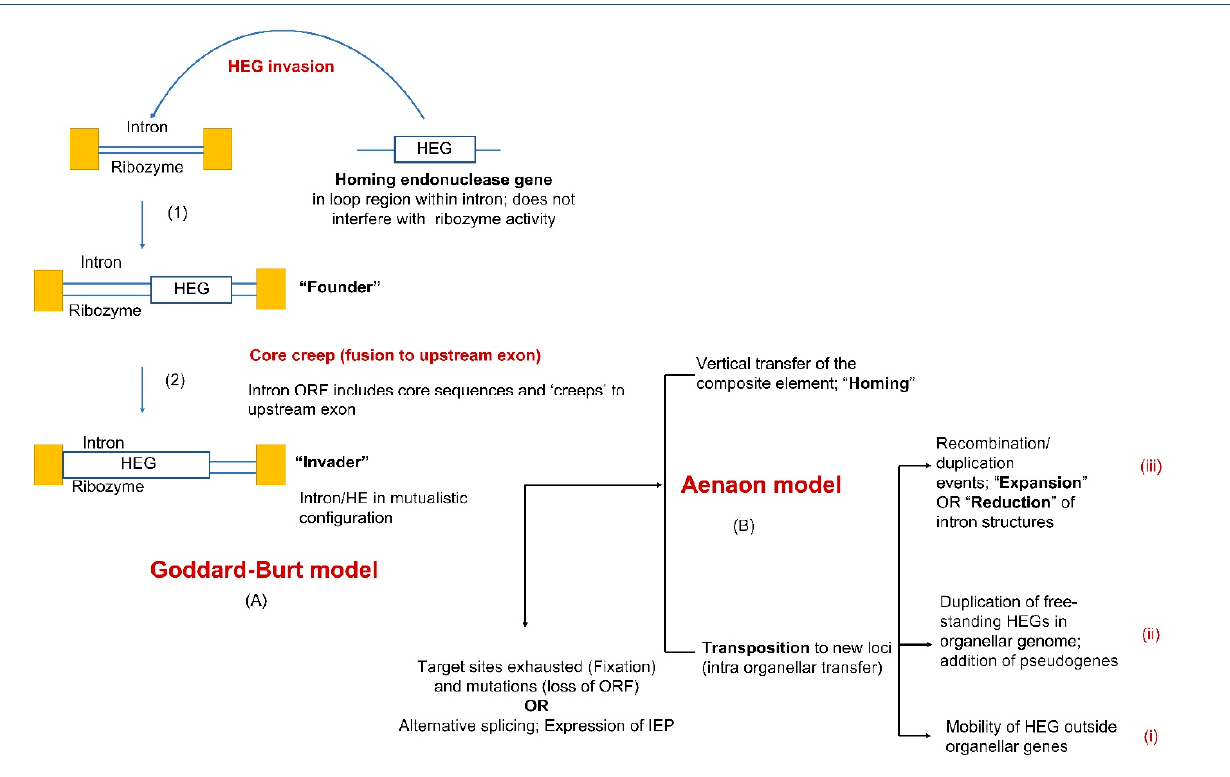
Figure 7. Comparison of the Goddard–Burt (as modified in [138]; copyright license number 5111000556510) and the aenaon models of intron/HEG evolution. In the first step, the HEG invades and resides within the intron and does not interfere with its catalytic activity. This element is called the ‘founder’ mobile intron. Intron ORFs, over time, expand and the ORF includes intron core sequences and creeps towards the upstream exon by ‘core creep’. The result is fusion of the intron ORF to the upstream exon. In the ‘invader stage’, the intron/HE combination has established a mutualistic configuration that minimizes the impact on the host gene and favors the expression of the IEP which would increase the probability of intron mobility and efficient intron splicing [138]. As suggested by Goddard and Burt, once a mobile intron has exhausted its target site and undergone fixation, accumulation of introns may lead to the loss of the intron ORF fused to the upstream exon [203]. This cycle ties into the aenaon model [133], to explain the fates of the introns on homing and transposition both at inter and intra-organellar levels. Upon transposition to new sites within the organelle, the composite intron-HEG element can (i) show mobility outside the organellar genes; (ii) free-standing HEGs can undergo duplication within the organellar genome, with probable addition of pseudogenes due to drift; (iii) genetic recombination and duplication can lead to either expansion or reduction in intron RNA structures.